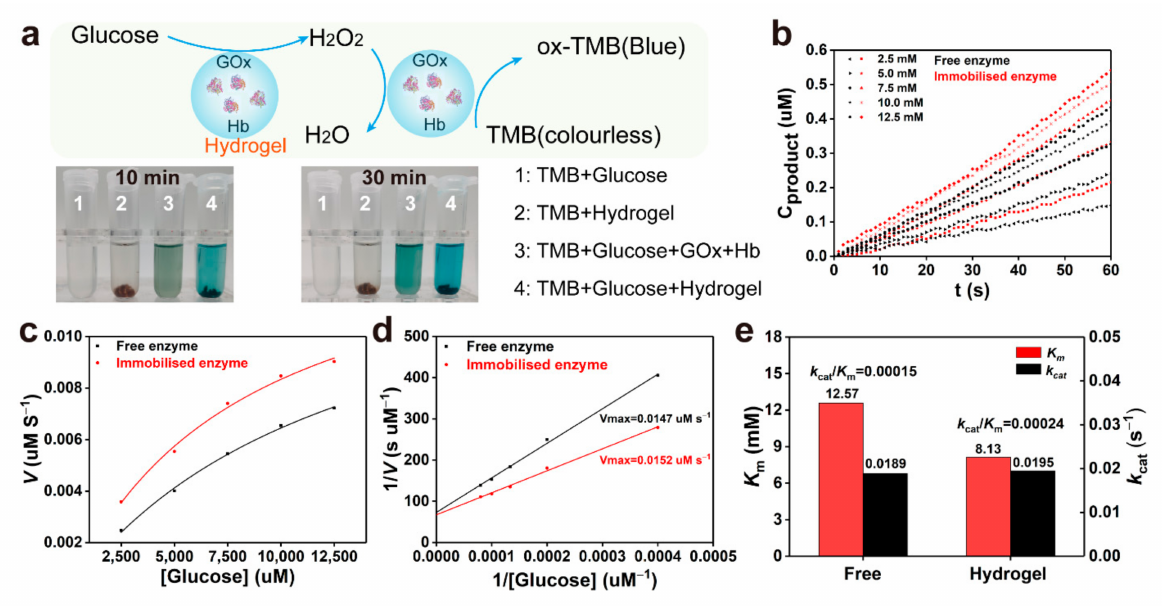
Figure 5. The catalytic activity of the free and immobilised enzyme. ( a ) Mechanism of tetramethyl- benzidine (TMB) oxidation and time-dependent absorbance changes at 25 ◦ C. ( b ) Catalytic reactions during the first minute of the free and immobilised enzyme with different glucose concentrations. ( c ) Michaelis–Menten kinetics of TMB oxidation catalysed by free and immobilised enzyme. ( d ) The Lineweaver–Burk plots of free and immobilised enzyme. ( e ) Comparison of catalytic activity between free and immobilised